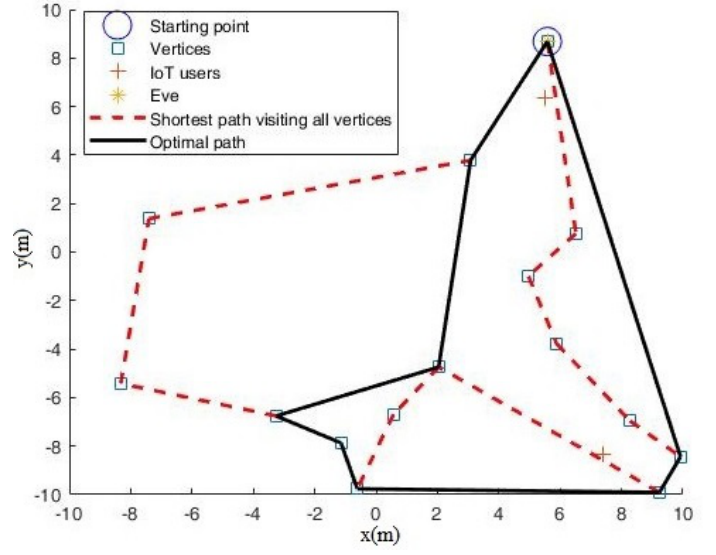
Figure 6. Selected path for mobile relay with M = 15 when noise power σ 2 e = − 90